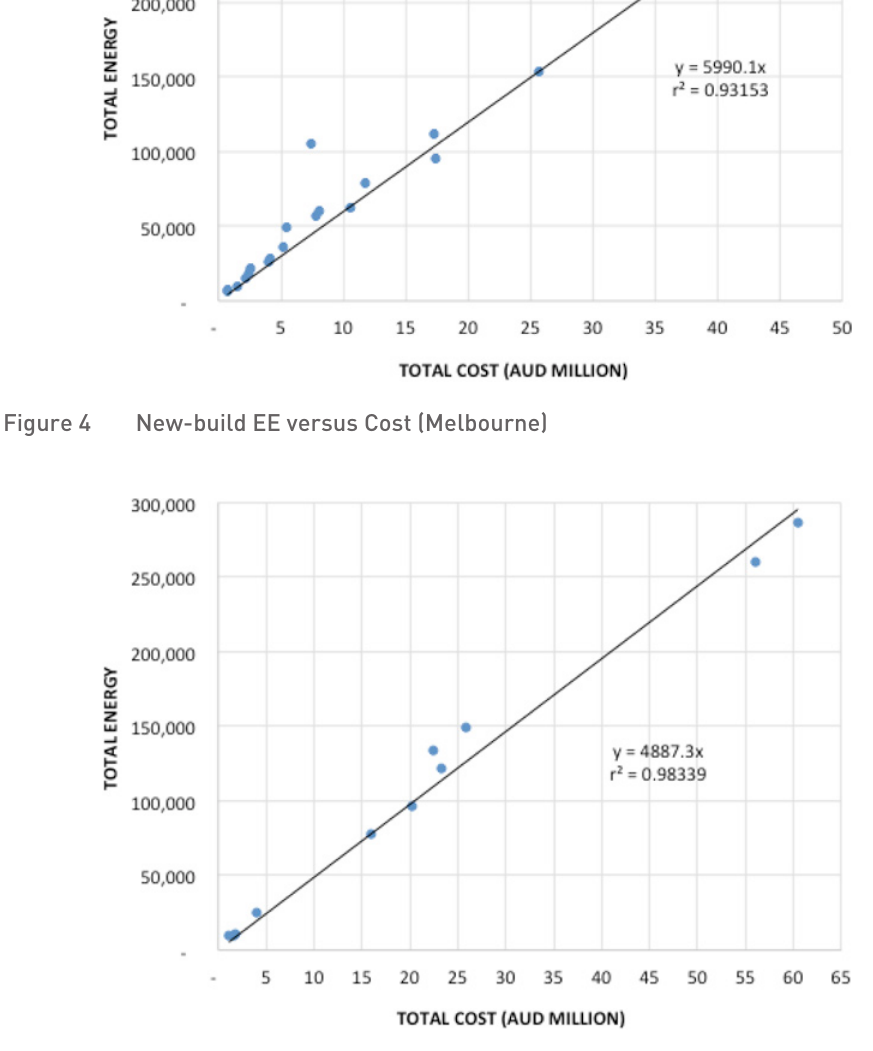
Figure 5 Refurbished EE versus Cost